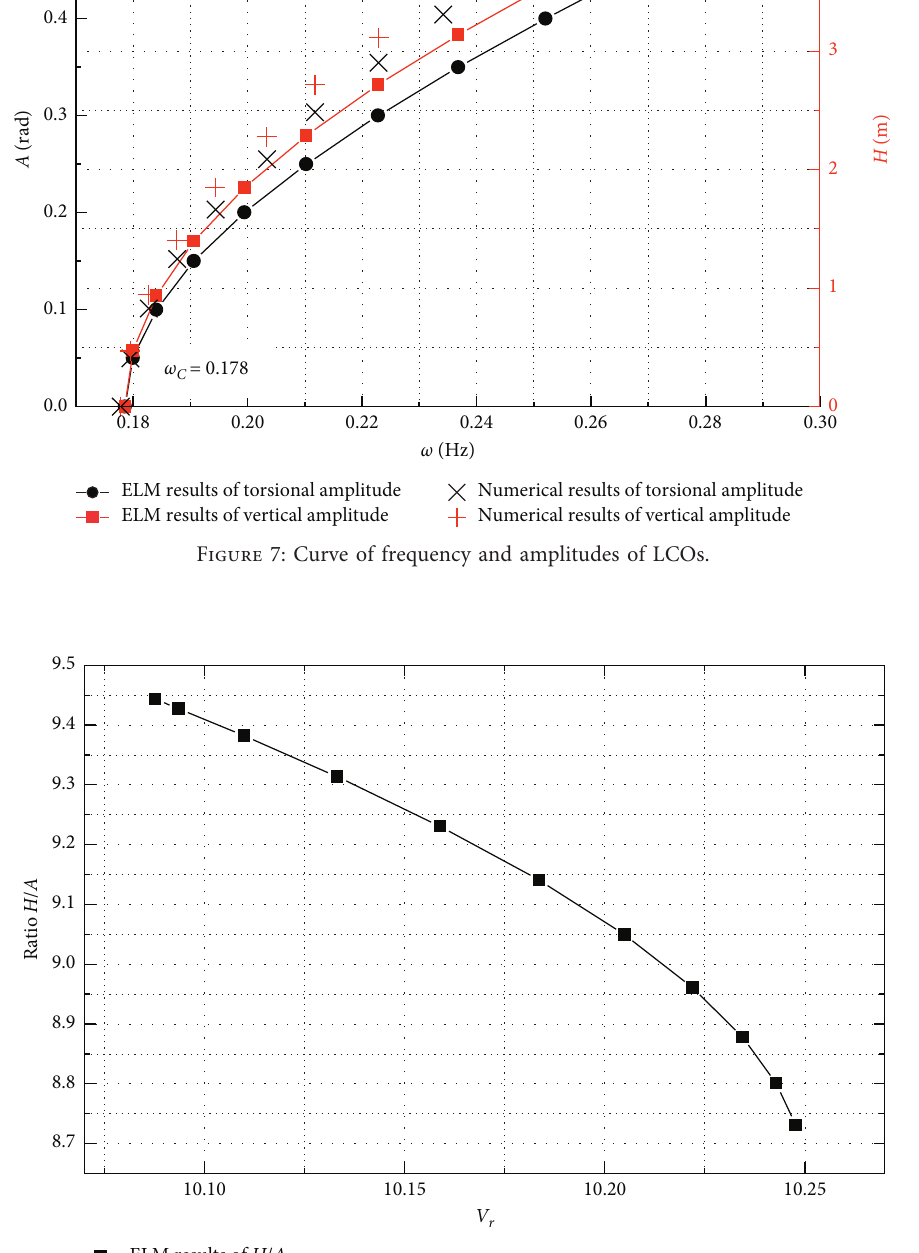
Figure 8: Curve of reduced wind speed and vertical-torsional